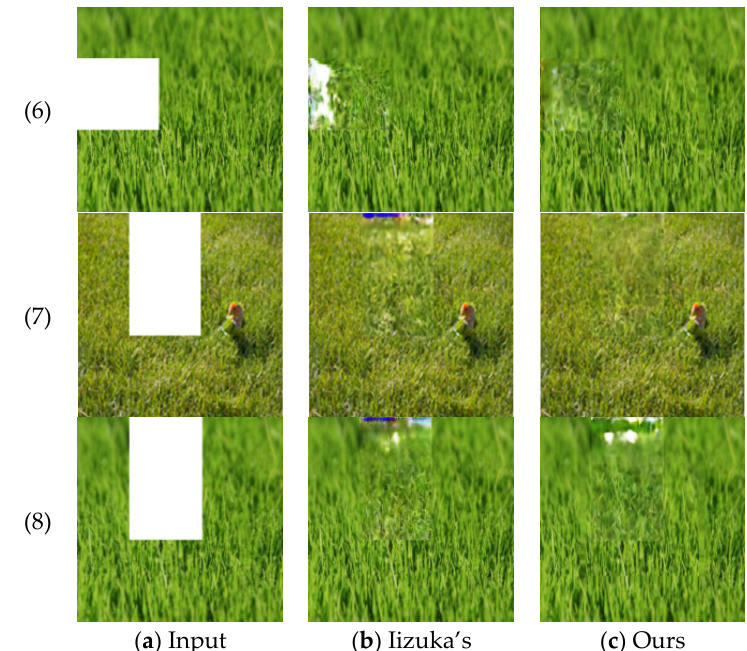
Figure 4. The result of Iizuka’s ( b ) method and ours ( c ). ( a ) Input.